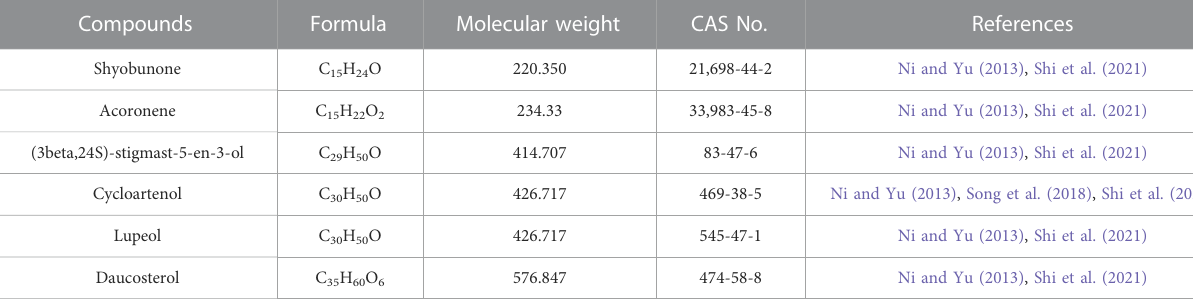
TABLE 3 The organic acids composition in ATR. Compounds Formula Molecular weight